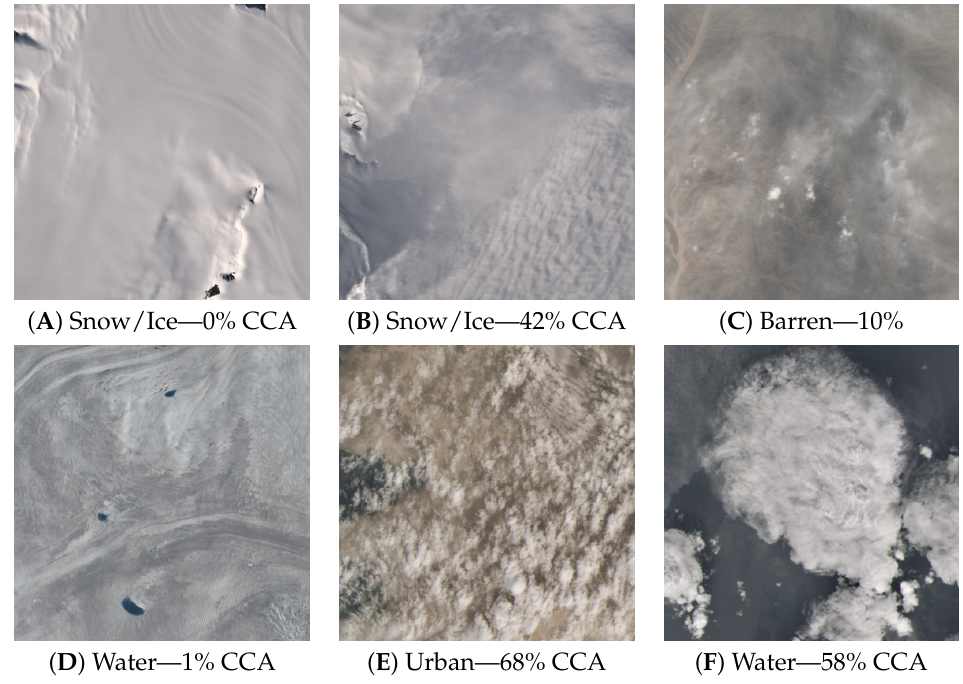
Figure 10. False positive tile examples: ( A , B ) represent the Snow/Ice biome; ( C , D ) represent cloud- like FP tiles; ( E , F ) represent FP tile close to threshold